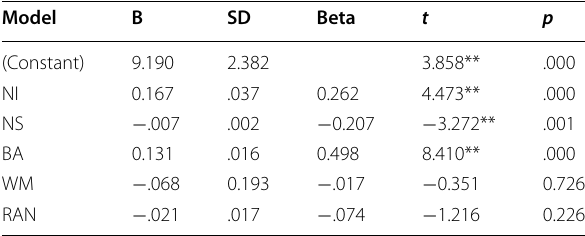
Table 2 Regression analyses of mathematical